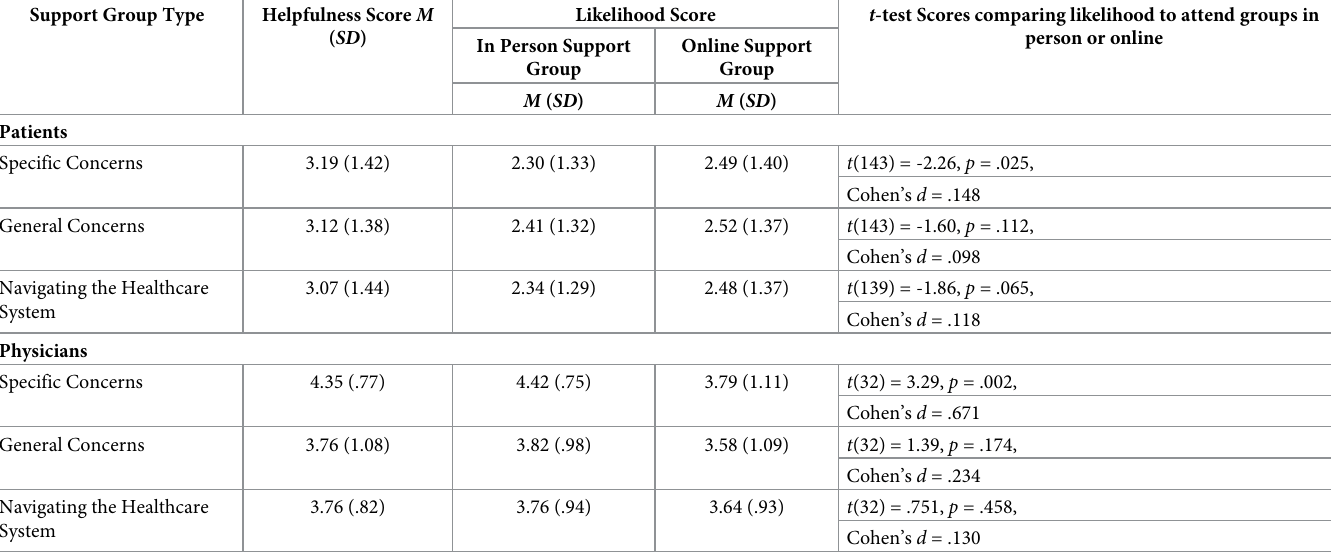
Table 6. Descriptive statistics for patients’ and physicians’ responses to the helpfulness of peer support groups for trauma survivors and the likelihood of either joining or referring patients to in person and online groups.